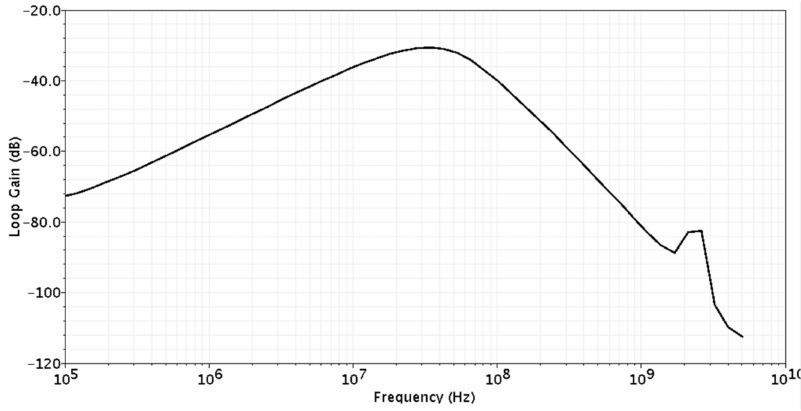
Figure 4. Simulated loop gain versus frequency at the LO frequency of 2.4 GHz.